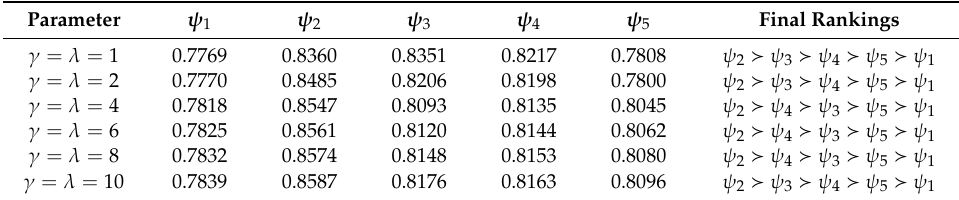
Table 6. Score values by using GWSVNPSCW operator.